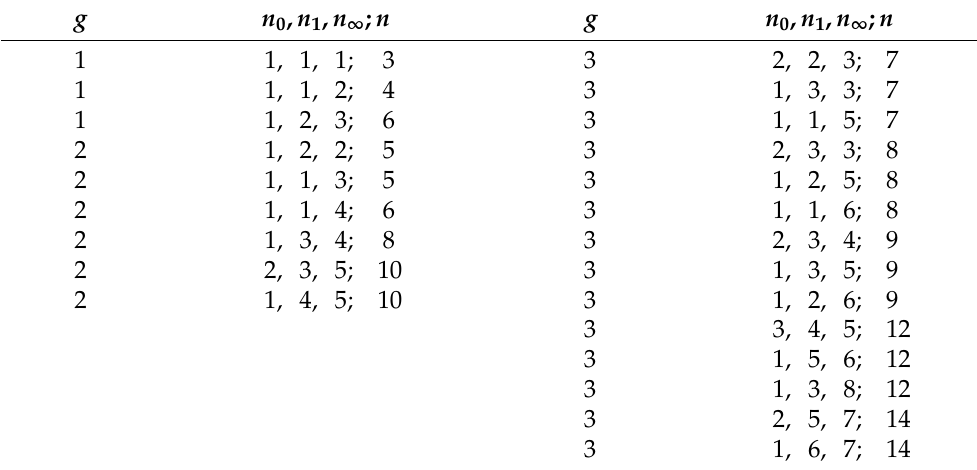
Table 1. Based on the table in Aurell and Itzykson ([1], p.